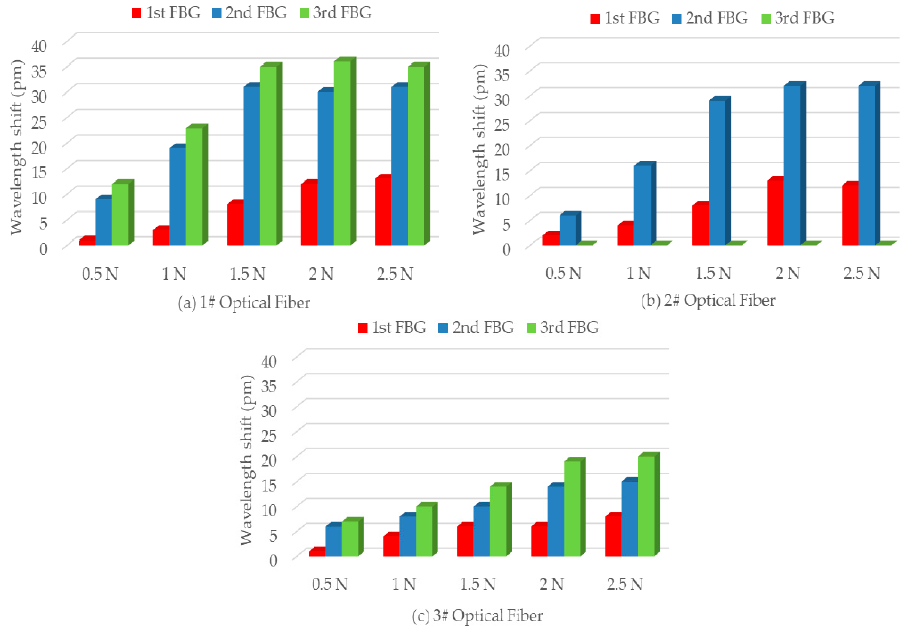
Figure 7. The relationship between wavelength shifts of FBG strain sensors and simulated glaze icing load. ( a ) The wavelength shifts of FBG strain sensors in 1# Optical Fiber; ( b ) The wavelength shifts of FBG strain sensors in 2# Optical Fiber; ( c ) The wavelength shifts of FBG strain sensors in 3# Optical Fiber.